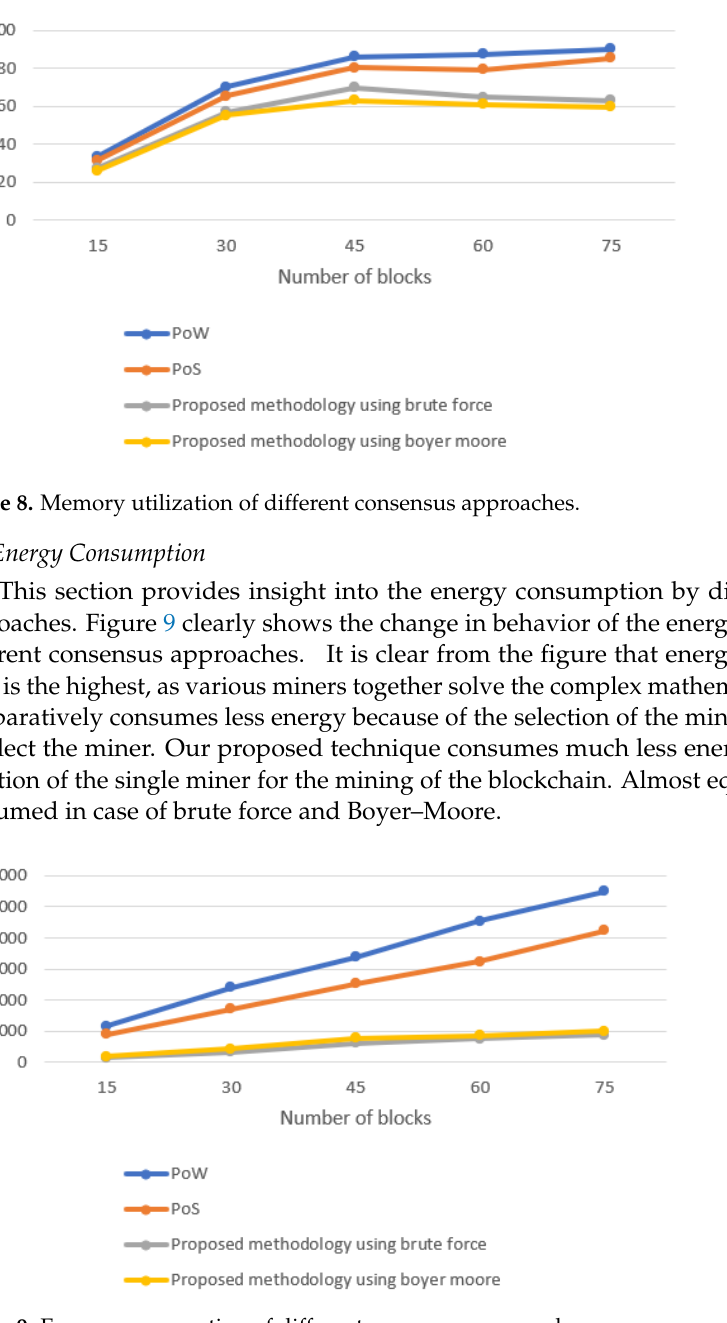
Figure 9. Energy consumption of different consensus